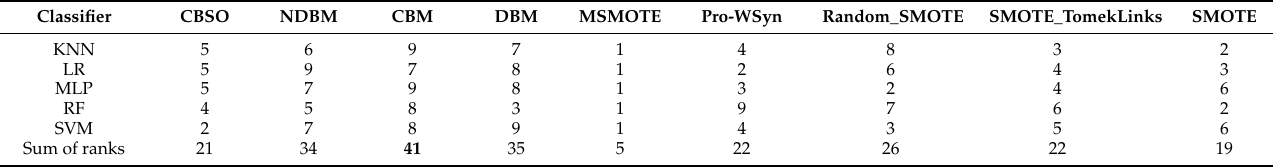
Table 12. Friedman sum-of-ranks test on Opportunity-based results for all methods and classifiers. CBM is the overall highest ranking